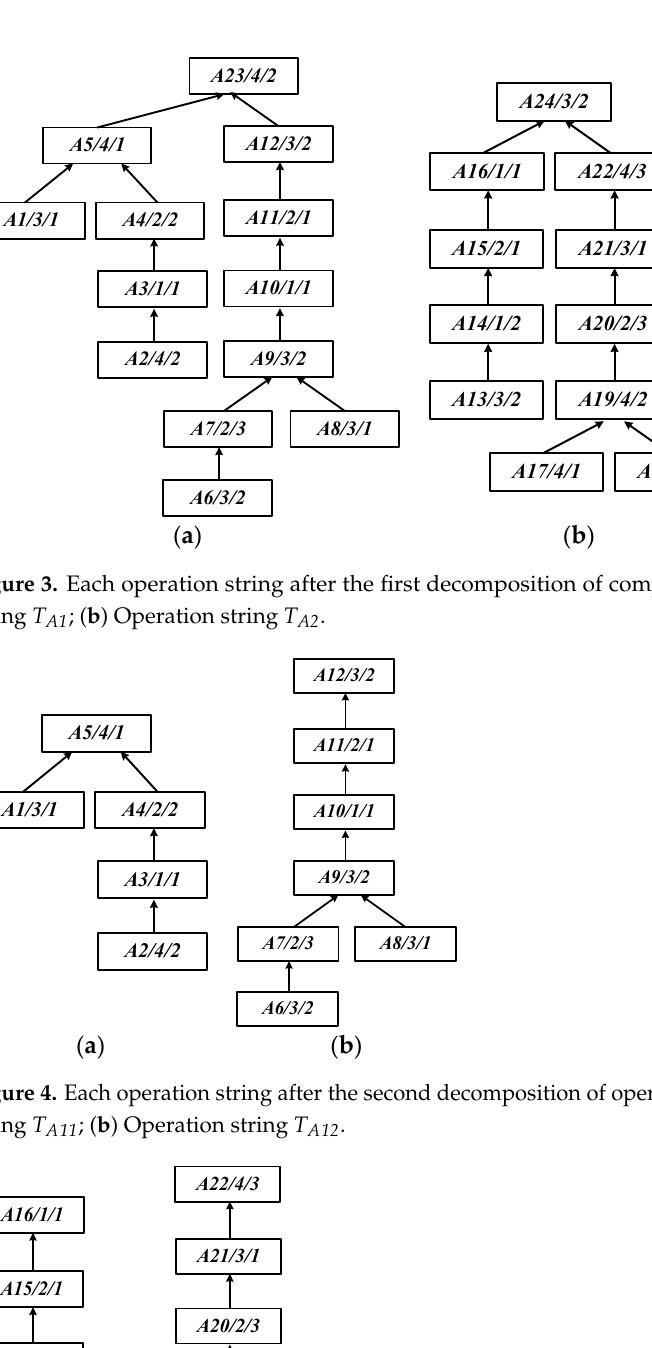
Figure 4. Each operation string after the second decomposition of operation string T A1 : ( a ) Opera ‐ tion string T A11 ; ( b ) Operation string T A12 .